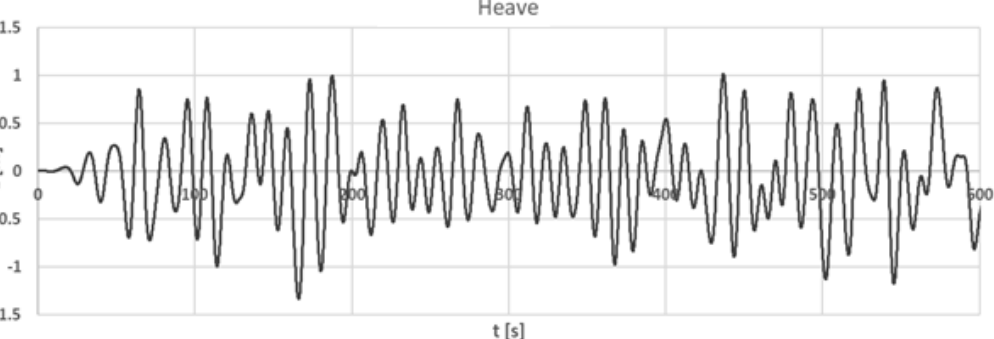
Figure 18. Heave response to IW8 according to the coupled time − domain solver SESAM DeepC ® .